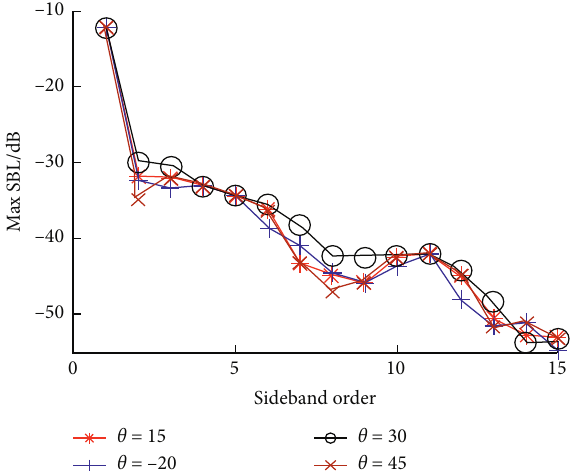
Figure 12: Optimized pattern at the center frequency and at the front three sidebands of time modulated array. . 1